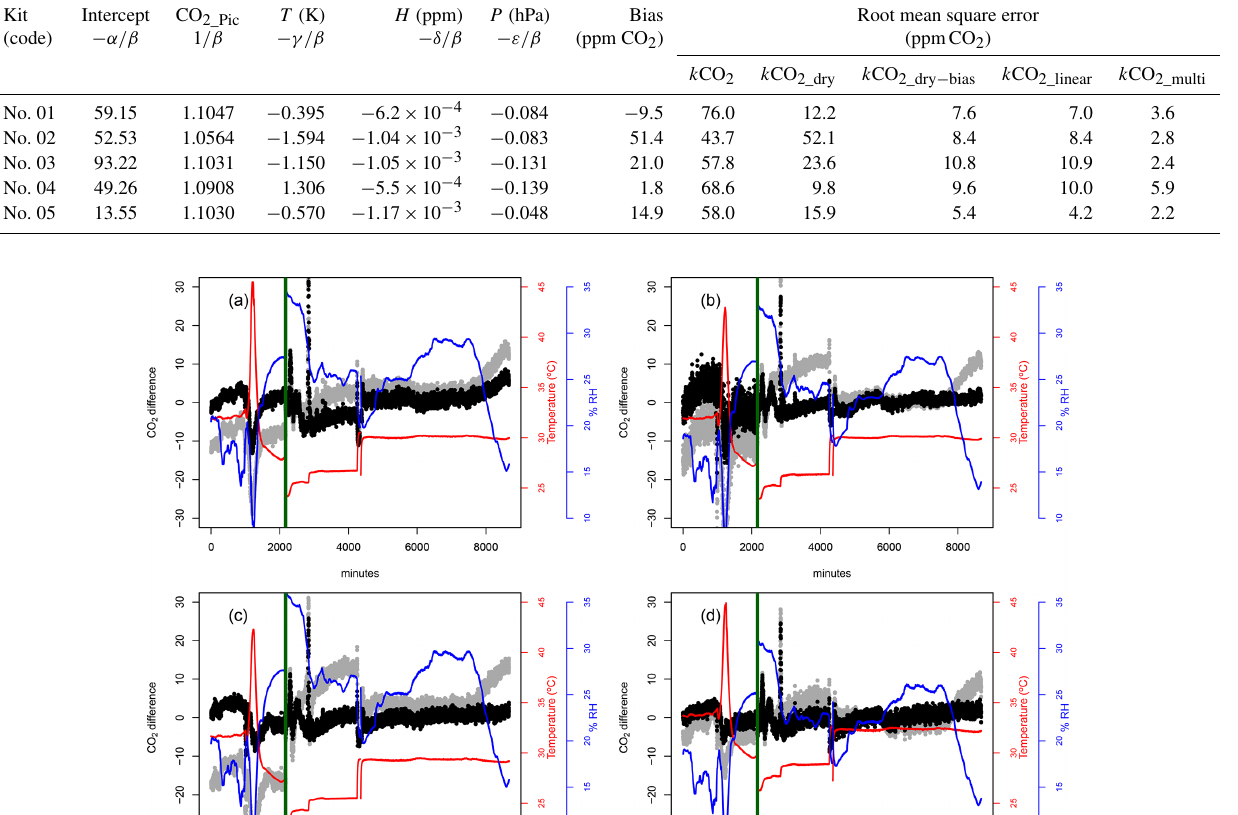
Table 2. Parametric fitting for calibration of CO 2 air enquirer sensors.